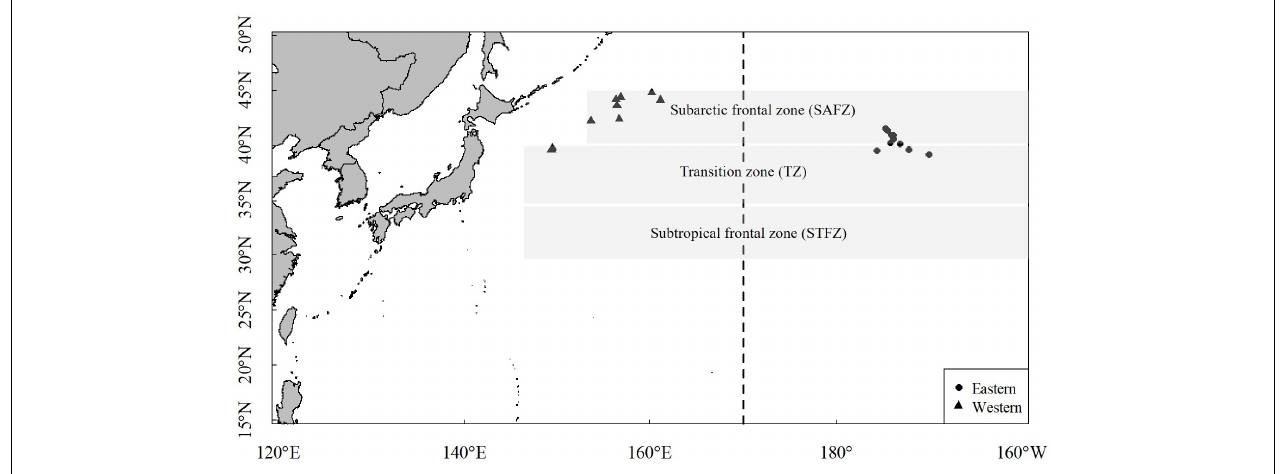
FIGURE 1 | Sampling stations of Ommastrephes bartramii in the North